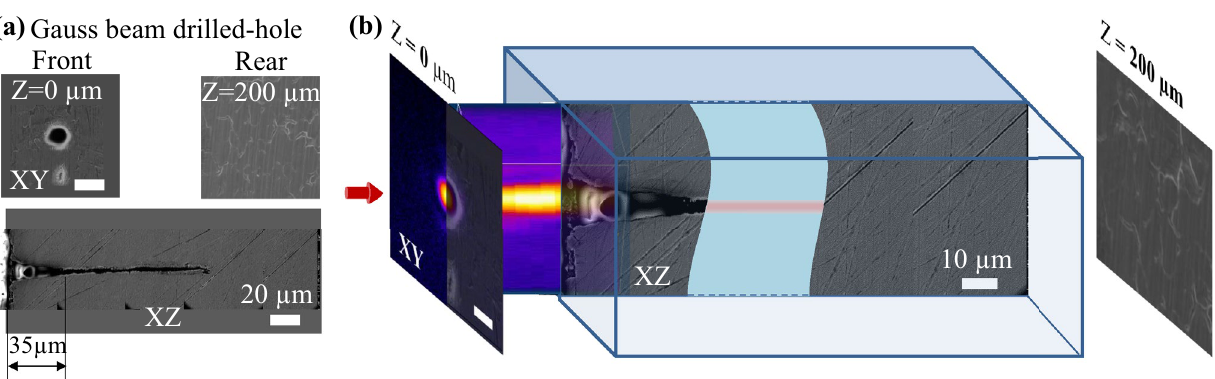
Figure 7. ( a ) SEM images of the blind hole drilled in (not through) the 200 μm plate by the Gaussian beam 0 ) whose at the laser fluence F g = 6.25 J/cm 2 . Upper images show top-view surfaces of the hole front ( Z = 200 μm) indicating the blind end. Lower topography resembles the Gaussian beam profile, and the rear ( Z = image displays cross-sectional profile of the hole along the longitudinal axis Z . The blind hole has a tapering 35 μm and a drilled depth of 135 μm. ( b ) Matching of the Gaussian beam profiles to the surface distance Z tap ∼ topography of the drilled hole. The hole entrance diameter of 13 μm is larger than the Gaussian beam diameter 11